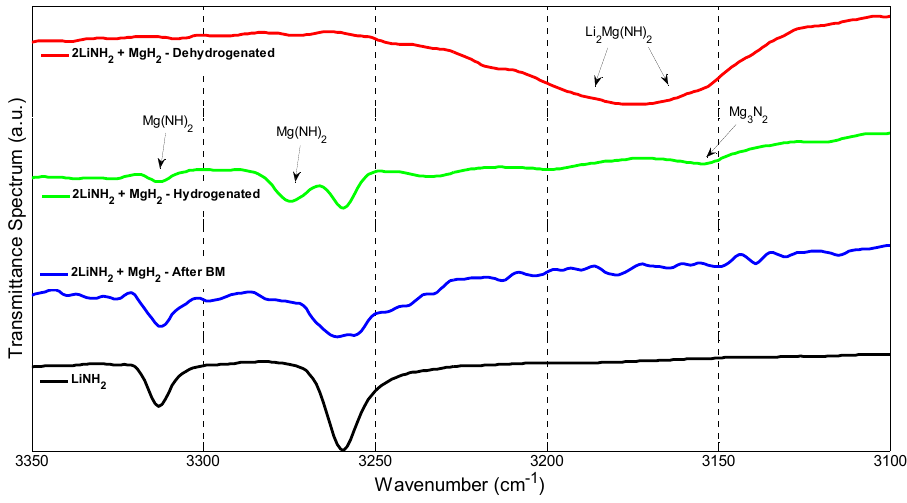
Figure 7. Fourier transform infrared spectroscopy (FTIR) spectra of LiNH 2 -nanoMgH 2 (2:1) before and after pressure composition temperature (PCT).